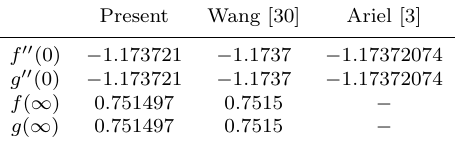
Present Wang [30] Ariel [3] f (cid:48)(cid:48) (0) − 1 .